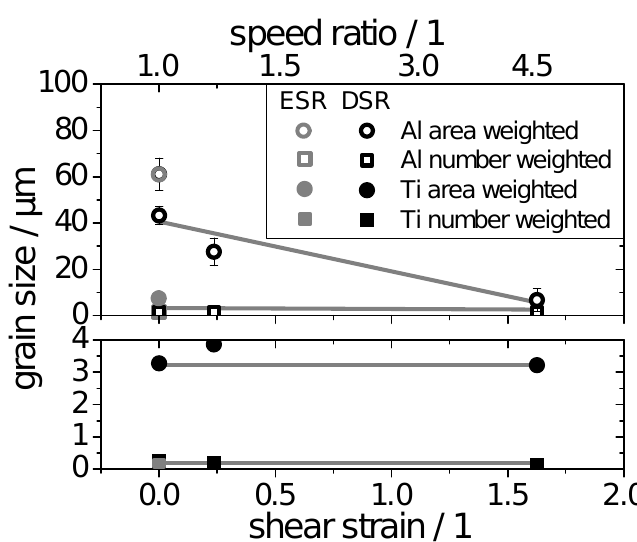
Figure 13. Grain size within the Al and Ti layers of a 160-layered Ti/Al composite sheet prepared by six ARB cycles and with three additional DSR passes with a speed ratio of up to 1:5. Gray colored data points correspond to samples being conventionally rolled up to the same shear strain.